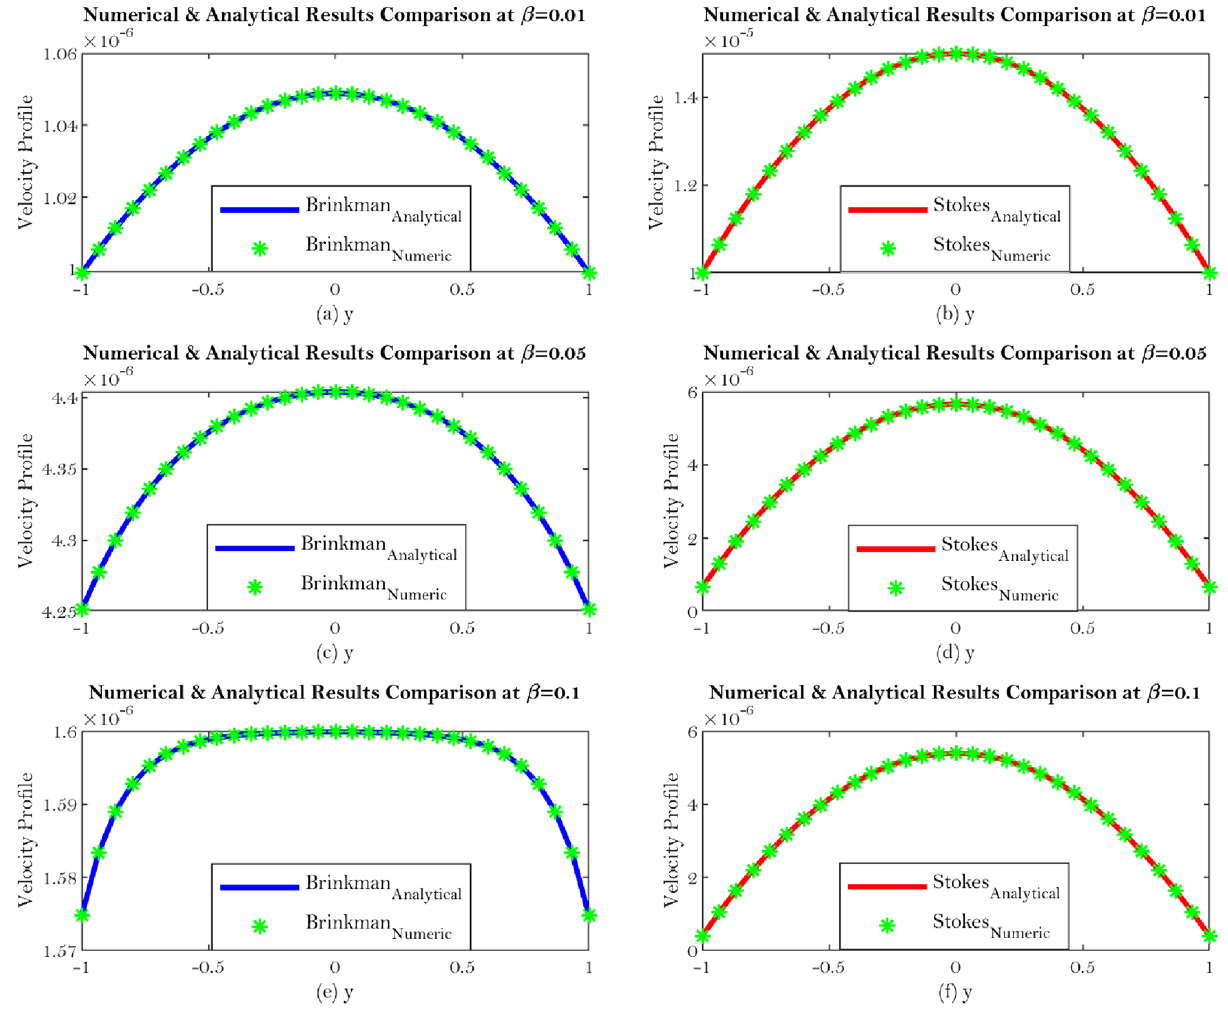
Figure 5. Shows velocity comparison at different value of the β such as β = 0.01, 0.05 and 0.1